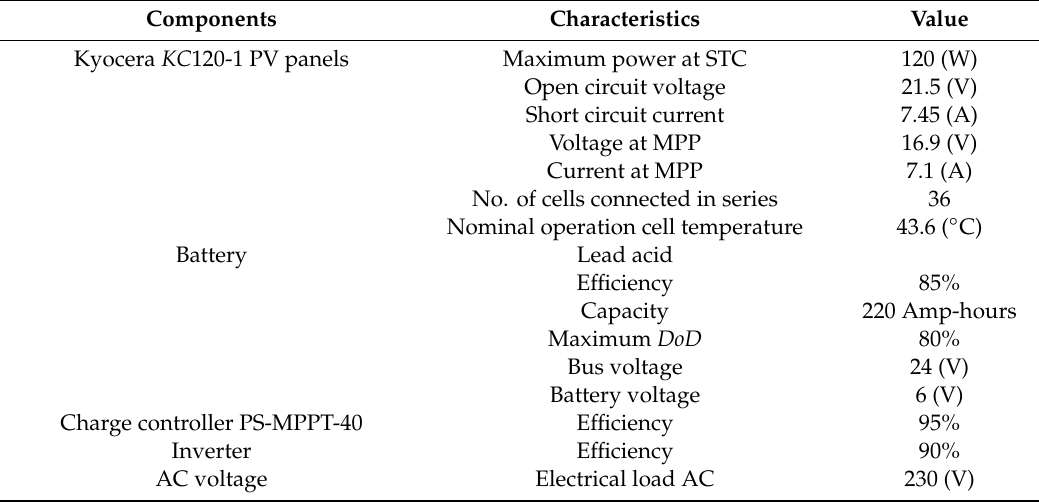
Table 1. Standalone photovoltaic (SAPV) system’s key specification